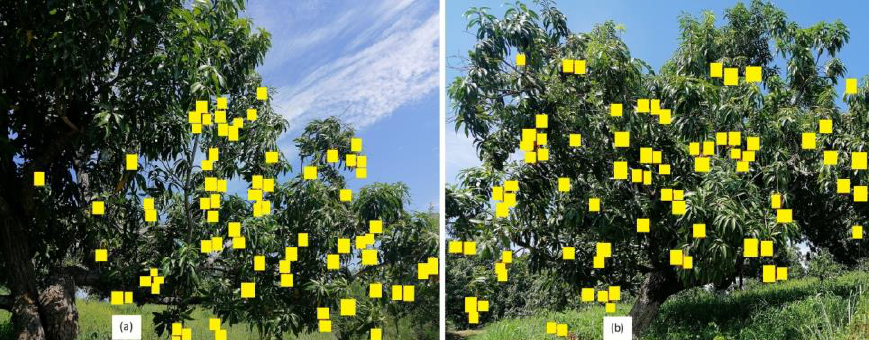
Figure 13. Counting of mango fruits in a mature tree using vision techniques on ( a ) the front and ( b ) the lateral side.